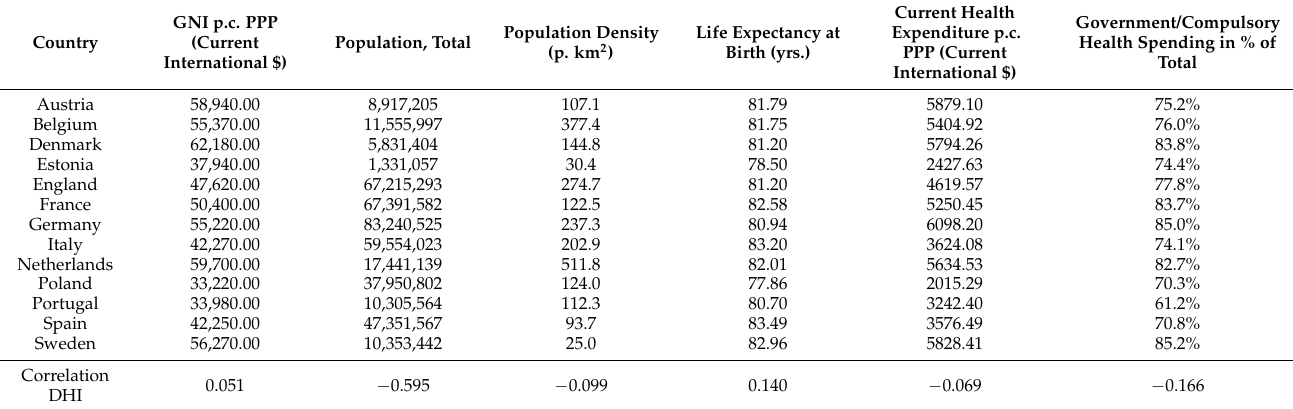
Table 2. Country Statistics (Selected OECD-countries). Source: Own compilation based on data of OECD and World Bank [59,60]. GNI p.c. PPP Country